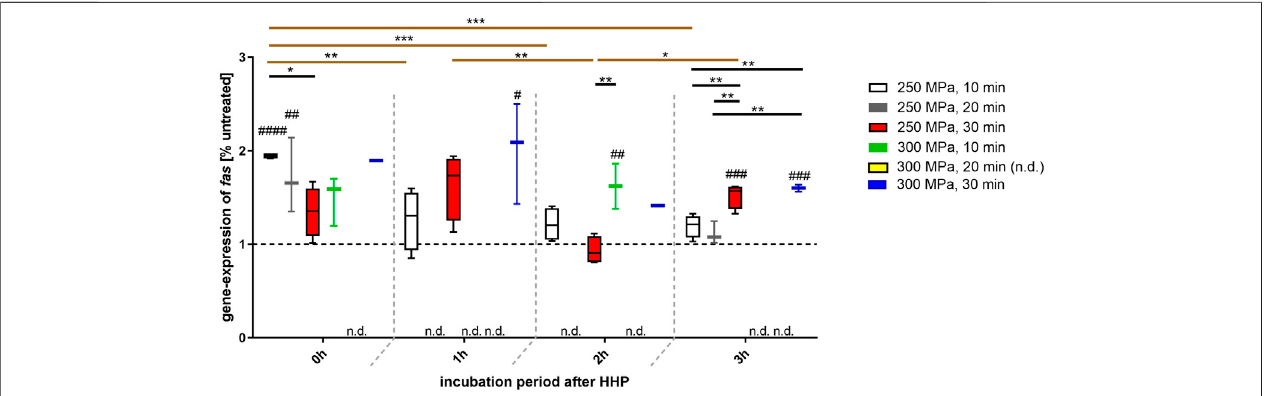
FIGURE 4 | Geneexpressionof fas inhumantrabecularbonefollowingHHP-treatment.Dataaredepictedasboxplotswithmeansandinterquartilerangesfrom25to 75%.Geneexpressionisshownaspercentageofuntreatedtissue(brokenlineat1).StatisticalAnalysiswasperformedusingone-way-ANOVAandtwo-way-ANOVA( n (cid:2) 4) withBonferroni ’ s multiplecomparisontestasposthoc test. Signi fi cantly different fromuntreated control:# p ≤ 0.05; ## p ≤ 0.01; ### p ≤ 0.001;#### p ≤ 0.0001. Signi fi cant differences between HHP-treatments: * p ≤ 0.05; ** p ≤ 0.01; *** p ≤ 0.001. Black lines show signi fi cant differences between the different treatments within the same incubation period, brown lines show signi fi cant differences between the same treatments at different points of incubation time. Abbreviations: n.d. (cid:2) not detectable.